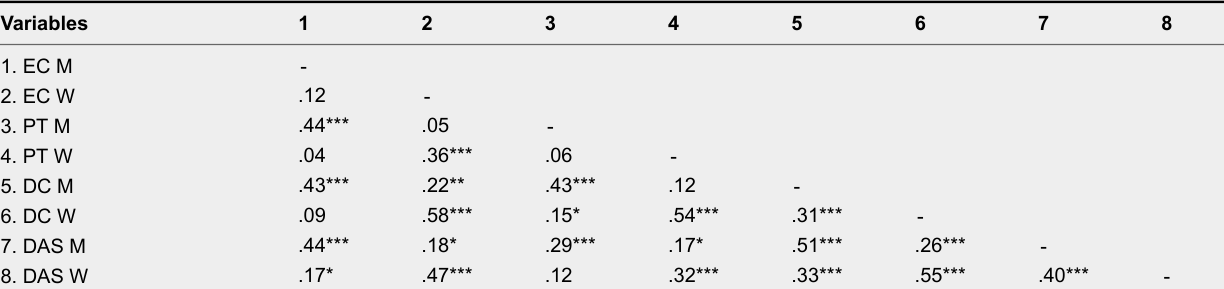
Correlations Between Dyadic Empathy, Dyadic Coping, and Relationship Satisfaction Among Men and Women